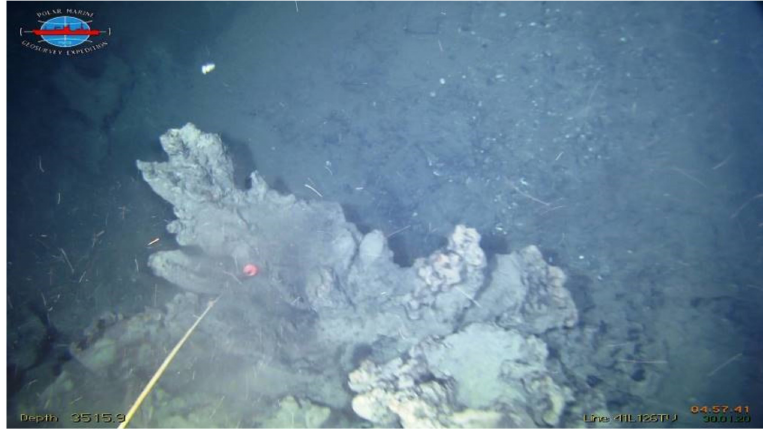
Figure 8. Inactive sulfide-rich chimney structures. Field Molodezhnoye. The chimney structures of the Molodezhnoye field are distinctly zoned. These include an outer opal–sulfide zone and an inner chalcopyrite-bornite zone. The channels are often inlaid with opal and are usually not clogged (Figure 9). Chalcopyrite in the inner zones forms rather large crystals (up to 2 mm), and sometimes forms aggregates. Nests of fine-grained sphalerite are observed. The amount of bornite gradually increases towards the outer zone. The outer part is represented by opal-sulfide aggregates dominated by chalcopyrite and bornite. Opal overgrows crystals of sulfides. Vein-disseminated ores of the Molodezhnoye field are represented by nested and vein pyrite mineralization in calcified